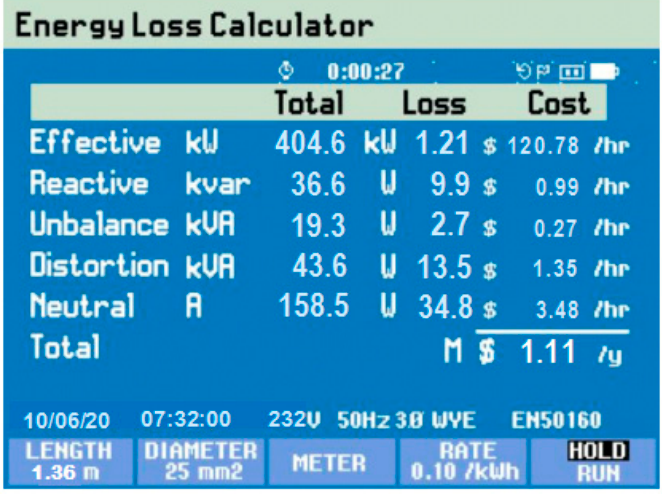
Figure 3. Loss calculator screen from the analyzer Fluke 435 Series